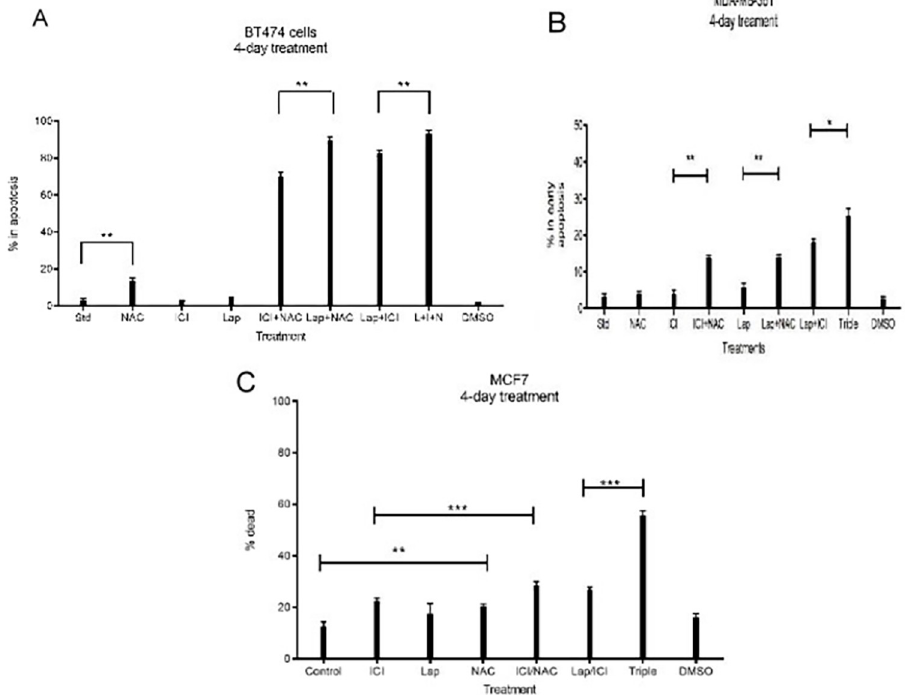
Fig 6. Investigating matriptase-directed 5mM NAC treatment resulted in increased apoptosis alone or in combination with ICI and/or Lapatinib in ER-positive breast cancer models. 100,000 A) BT474, B) MDA-MB-361 and C) MCF7 cells /well were seeded in 6-well plates and allowed to attach overnight. Cells were then treated with 5mM NAC, 5.4 uM Lapatinib, and 1uM ICI alone or in combination in serum-replete media for four days. NAC was administered again on day 3. Cells were collected and apoptosis determined by Annexin V/Propidium Iodide staining. Graphs are representative of 3 biological replicates. BT474 control ( �� , p = .0017 vs NAC), Lap ( �� , p = .0013 vs Lap +NAC), Lap+ICI ( �� , p = .0044 vs triple), MDA-MB-361 ICI ( �� , p = .0014 vs ICI+NAC), Lap ( �� , p = .0028 vs Lap +NAC), Lap+ICI ( � , p = .0311 vs triple) MCF7 control ( �� , p = .0055 vs NAC), ICI ( �� , p = .0096 vs ICI/NAC),